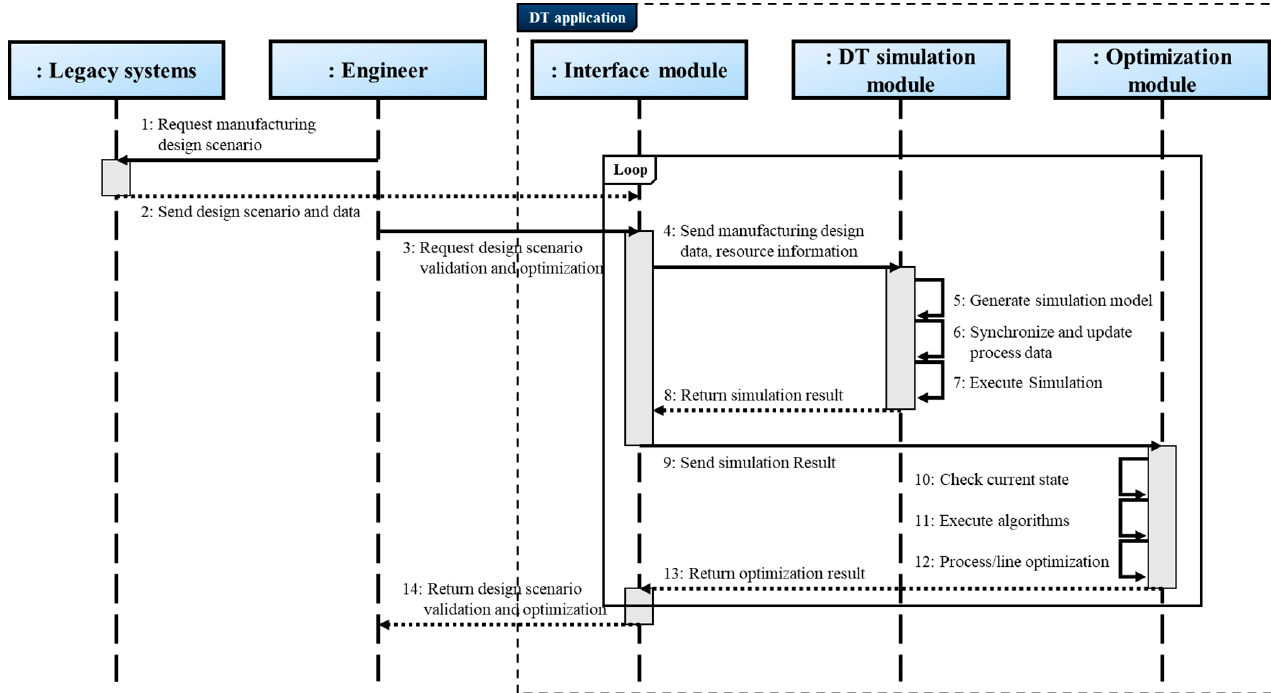
Figure 2. Operation procedure of DT application.